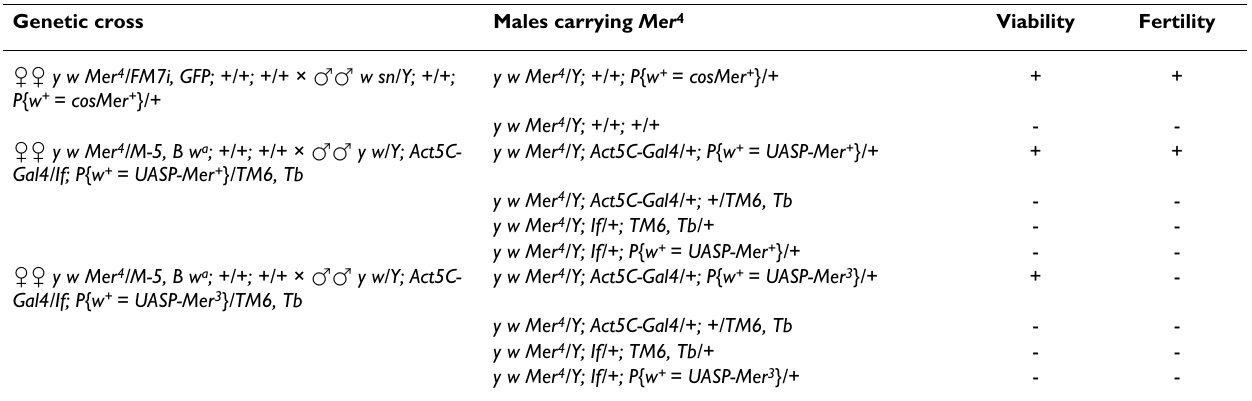
Table 1: The ability of various transgenes to restore the viability and fertility of the Mer 4 allele. Genetic cross Males carrying Mer 4 Viability